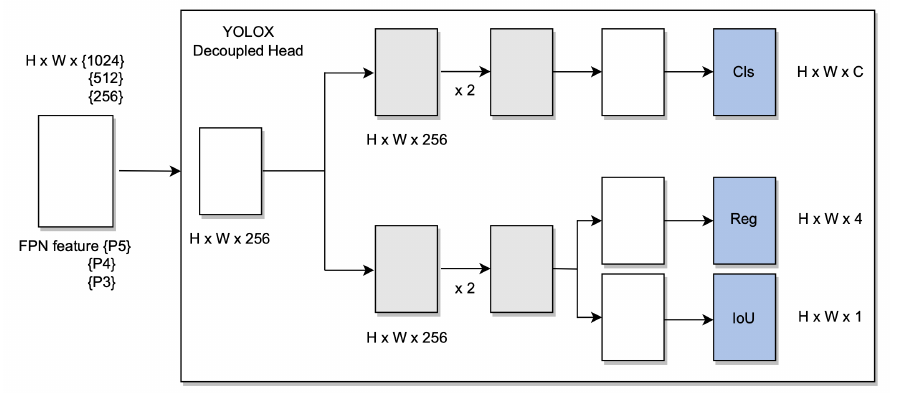
Figure 6. YOLOX system architecture.